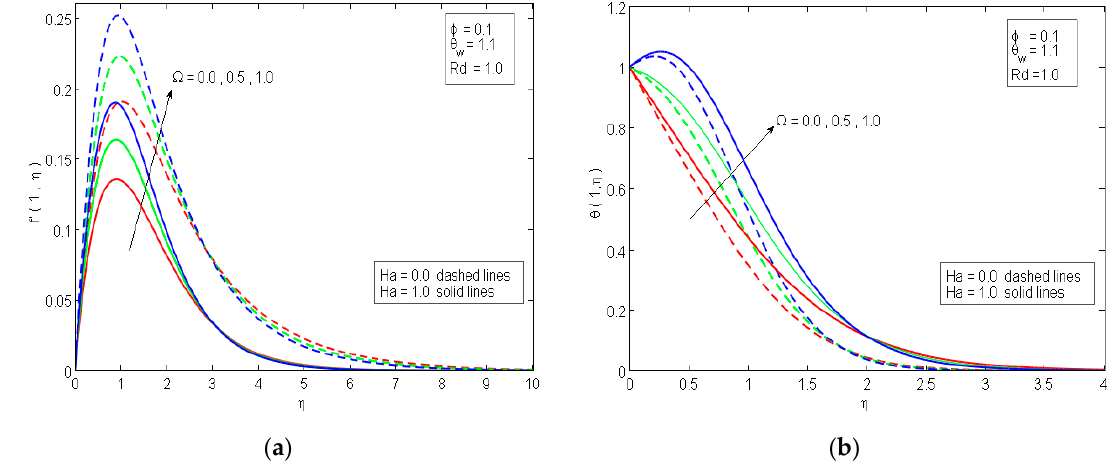
Figure 3. Effectiveness of Ha and Ω on velocity field ( a ) and on temperature field ( b ).